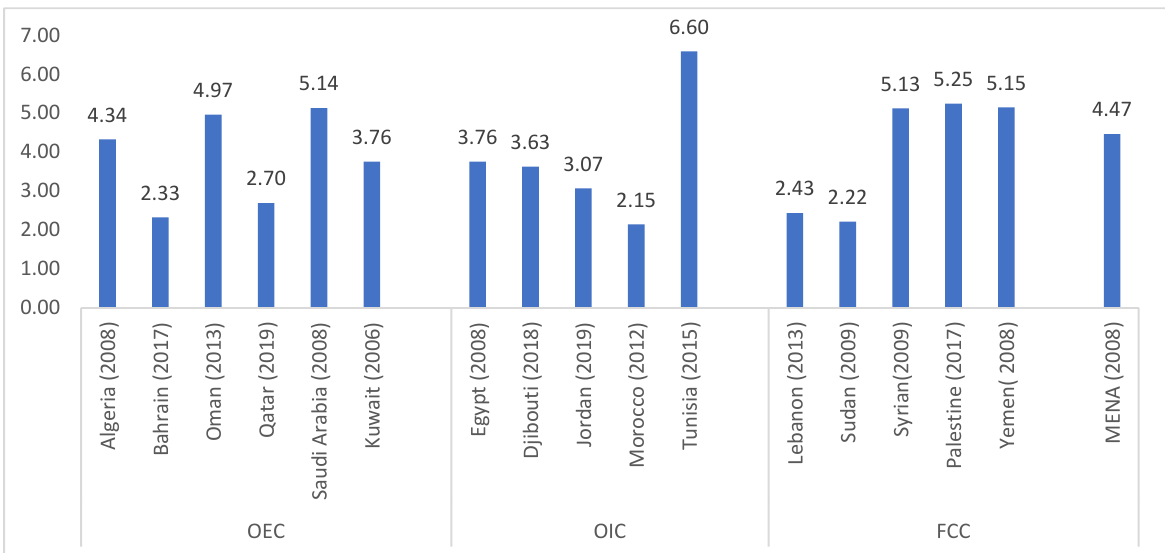
11 of 26 Figure 2. Current health expenditure in 2018 (% of GDP). Source : World Development Indicators. Available online: https://datacatalog.worldbank.org/ (accessed on 15 July 2021). Note: FCC: Fragile Crisis affected Countries, OEC: Oil Exporting Countries, and OIC :Oil Importing Countries. There are similar findings for education expenditure, as seen in the Figure 3 below. As shown, the highest expenditures on education were made in Tunisia (6.6% in 2015)